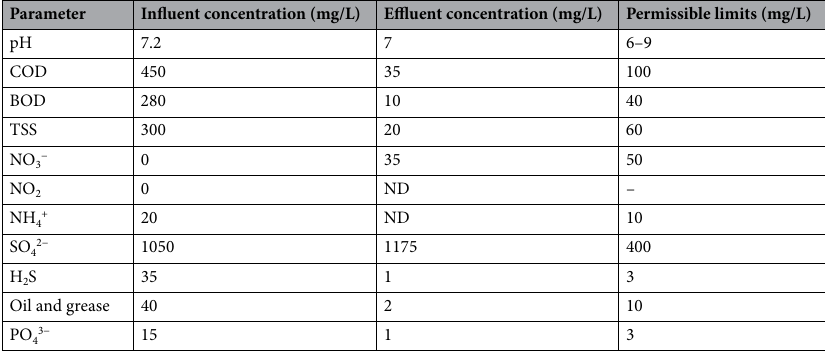
Table 2. Characteristics of influent in MASTP. All parameters in mg/L except for pH; ND is not detected (< 1 mg/L).